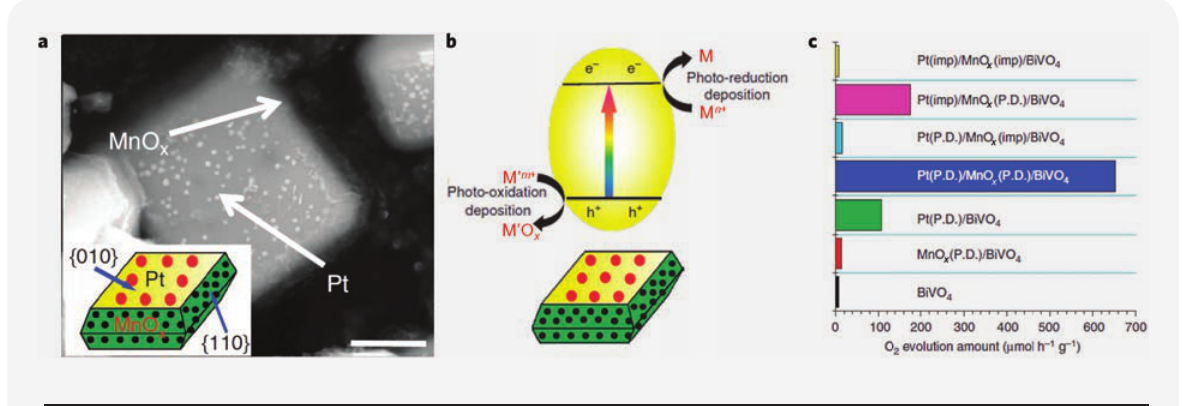
29.Figure 11. (a) SEM images of BiVO 4 -Pt-MnO x (b) Schematic representation of mechanism of water splitting on BiVO 4 -Pt-MnO x (c) Comparison of pho- tocatalytic activity of